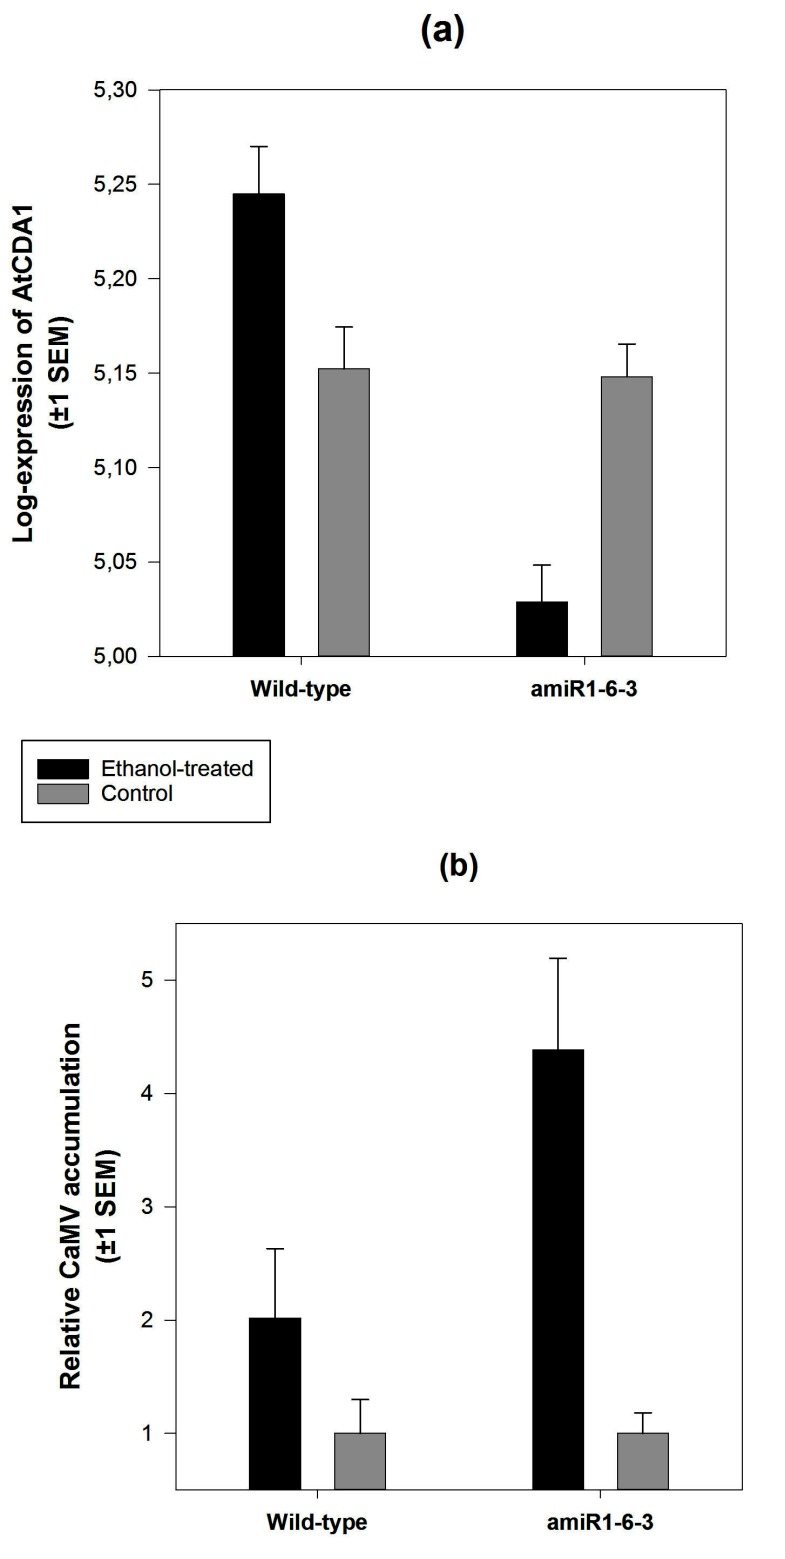
Accumulation of
AtCDA1 mRNA molecules and CaMV genomes.(
a) Number of
AtCDA1 mRNA molecules/80 ng total RNA quantified by RT-qPCR using the standard curve method for absolute quantification. (
b) Number of CaMV genomes/80 ng total DNA. For each block of plants (wild-type and amiR1-6-3), values were normalized to the average number of genomes estimated in the corresponding water-treated (control) plants.